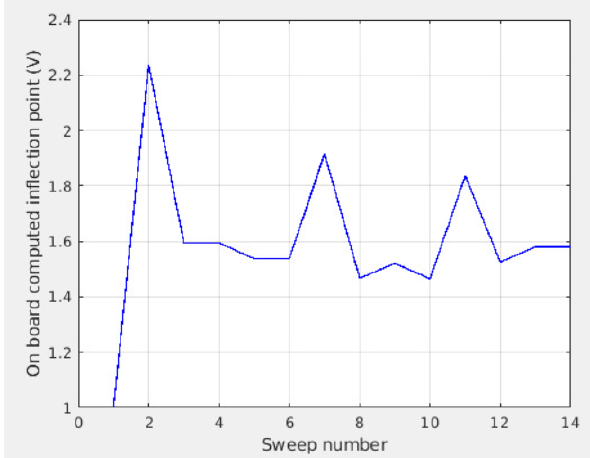
Figure 14. Inflection point computed on board SLP after each sweep for a series of 14 consecutive sweeps with 60 bias steps. Data were acquired in-flight on 30 January 2021 from 13:03:53 to